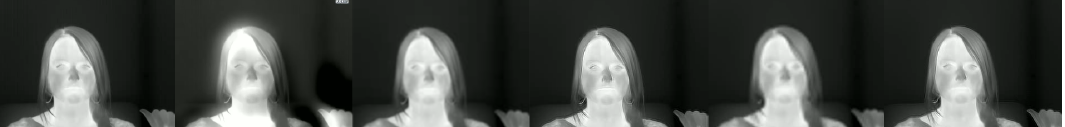
Figure 7. The corresponding frame extracted from the SC3000 8-bit sequences used in the study for respiratory rate evaluation. From the left: original, Eulerian Video Magnification, bicubic interpolation scale 2, super resolved using our model scale 2, bicubic interpolation scale 4, super resolved using our model scale